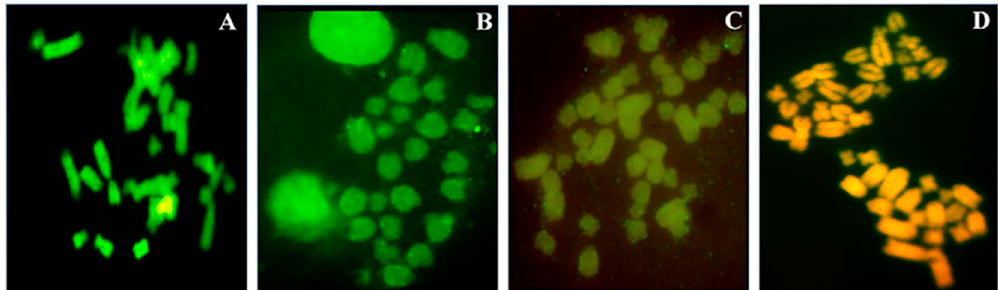
Figure 6. Chromosomal 5-methylcytosine indirect immunolocalization on metaphases of primary astrocytes and clones by anti-5-methylcytosine FITC-conjugate antibody. Representative metaphases of primary astrocytes ( A ), A-GS1 ( B ), A-VV5 ( C ) and A-FC6 ( D ). Green brilliant grains indicate high concentration of 5-meC, while a faint green fluorescence is due to a low level of methylation; when the green fluorescence is very low, the typical orange color of the propidium iodide counterstaining becomes predominant ( D ).